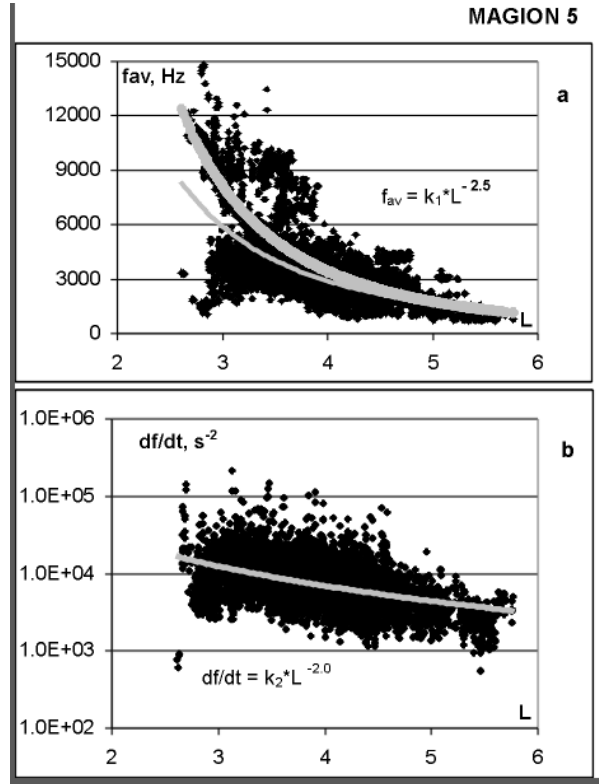
Fig. 3. (a) The center frequency of the chorus elements f av de- pending on L-shell. Thick grey line marks f H / 4, where f H is the electron gyrofrequency at the equator. The center frequency of the chorus band decreases with increasing L as L − 2 . 5 (thin grey line). (b) The frequency sweep rate of the chorus emissions depending on L-shell. The rate is rather high (higher than 10kHz/s) for about 30% of all elements analyzed. The mean sweep rate decreases with L-shell as L − 2 (grey